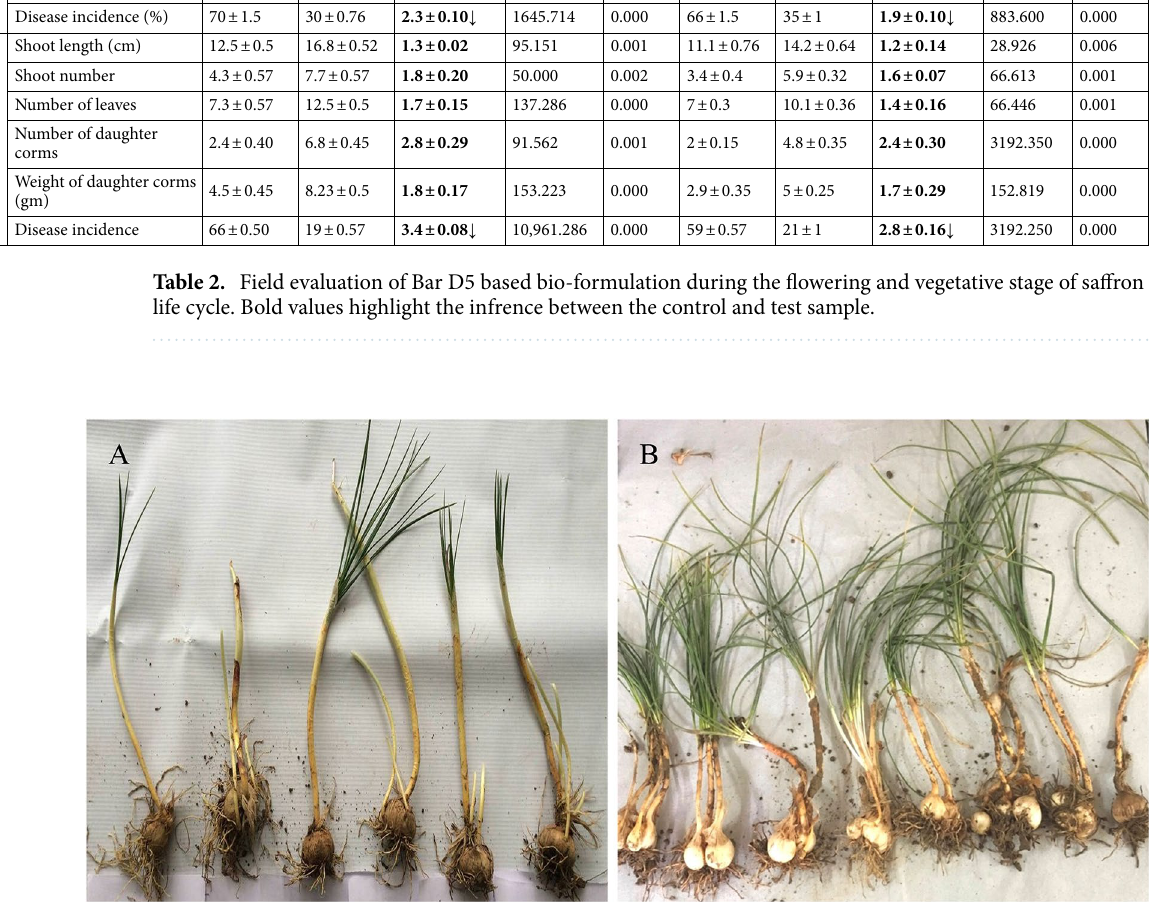
Figure 6. Comparison of plants samples obtained from the fields in Kishtwar in 2018. ( A ) Control samples and, ( B ) Plant samples treated with Bar D5 bio-formulation before sowing. The treated samples show better growth in terms of number and size of shoots and roots and production of daughter A comparison of the outcome of field trials in traditional and non-traditional area has been tabulated in Table 2. Genome analysis of Bar D5.